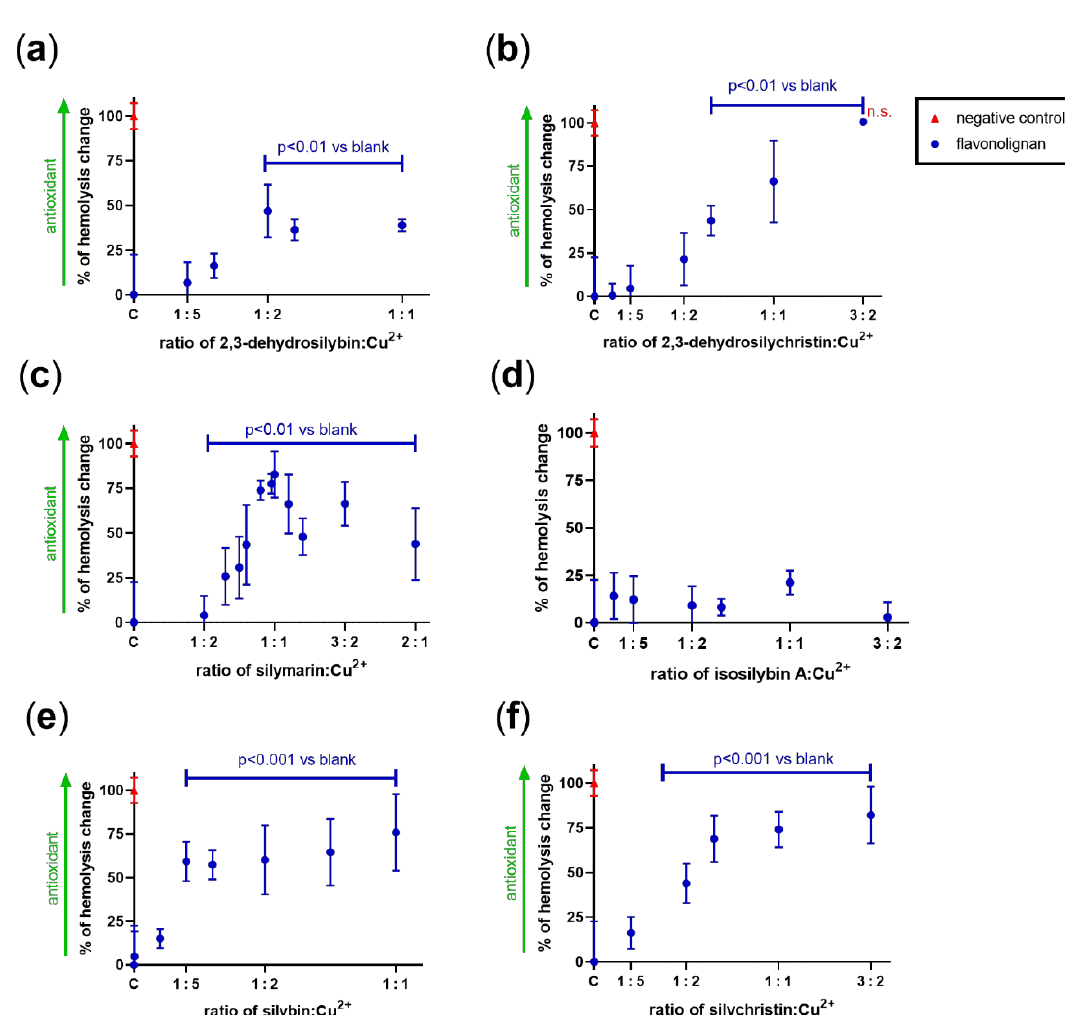
Figure 11. Effect of flavonolignans and silymarin on copper-triggered rat erythrocyte lysis: ( a ) 2,3-dehydrosilybin; ( b ) 2,3- dehydrosilychristin; ( c ) silymarin; ( d ) isosilybin A; ( e ) silybin; ( f ) silychristin. Only 2,3-dehydrosilychristin at the highest concentration fully abolished the hemolysis (non-significant difference vs. the negative control without copper). Some protective effect (shown in blue, significant vs. the blank, i.e., the positive control with copper) was observed in all cases except for isosilybin A. With silymarin, the molecular weight of silybin was used for calculations.